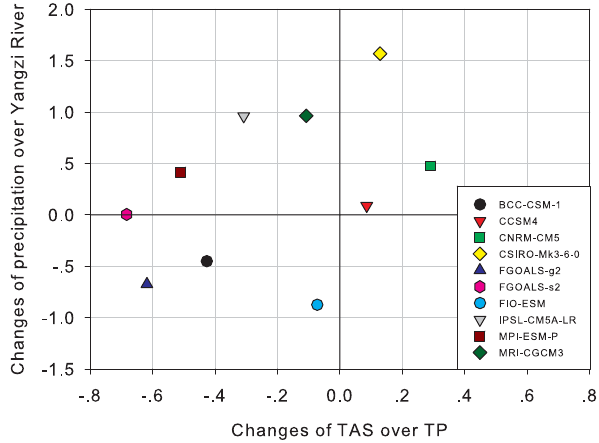
Fig. 8. The changes of precipitation in the lower reaches of Yangzi River (y-axis, mmd − 1 ) as a function of the changes of TAS (x- axis, ◦ C) over the Tibetan Plateau (TP, 85–95 ◦ E, 25–35 ◦ N) during boreal